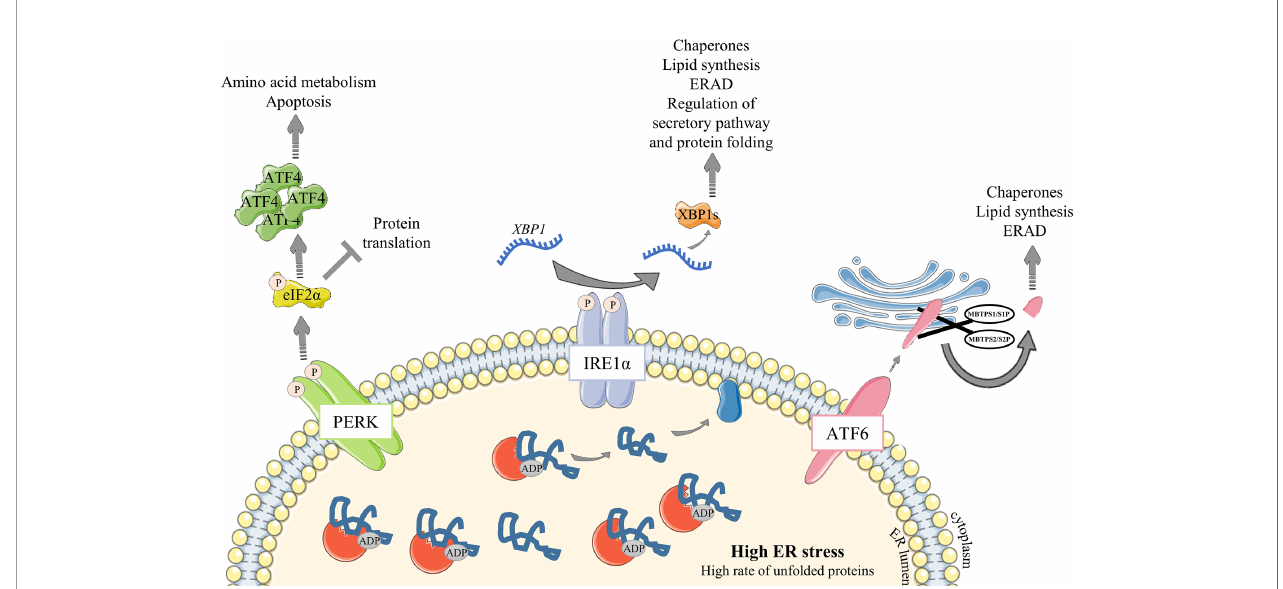
FIGURE 2 | Overview of the UPR signaling pathway under ER stress conditions. Unfolded Protein Response is engaged to respond to increasing amount of proteins in the ER. (1) The ER-resident chaperone BiP binds to unfolded and misfolded proteins and consequently releases the sequestrated IRE1 a , PERK and ATF6 ER sensors, leading to their activation following (i) dimerization and auto-phosphorylation of IRE1 a and PERK elements or (ii) MBTPS1 /S1P and MBTPS2 /S2P – mediated cleavage of ATF6 a in the Golgi apparatus. Activated ATF6 a then translocates into the nucleus and upregulates chaperones expression and factors involved in lipid synthesis and ERAD. Activated PERK phosphorylates eIF2 a which represses global protein translation except for ATF4 whose translation is enhanced. ATF4 then upregulates amino acid metabolism and apoptosis. IRE1 a , via XBP-1 transcription factor, leads to a broader range of responses with upregulation of many factors including chaperones and those important for lipid synthesis and ERAD. IRE1 a regulates as well the factors important for protein folding and secretory functions. Particularly, XBP1 mRNA requires IRE1 a to be spliced and ef fi cient as a transcription